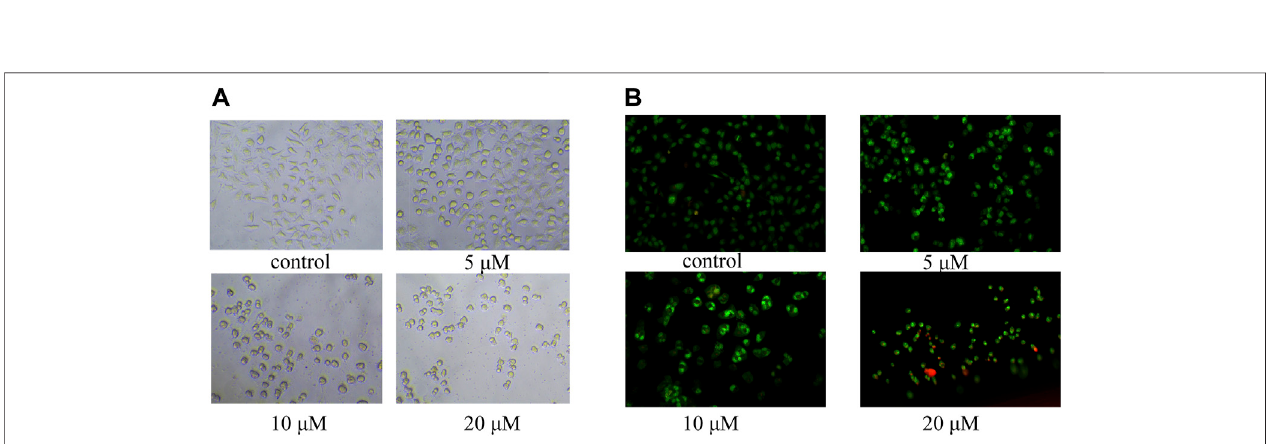
FIGURE 9 | Apoptosis induced by siragrosvenin D in MCF-7 cells detected by the fl uorescence microscope. (A) Morphology of the cells after being treated with siragrosveninD(0,5,10,and20 μ M)for24 h. (B) PercentageofapoptoticcellsbyAO/EBstainingafterbeingtreatedwithsiragrosveninD(0,5,10,and20 μ M)for24 h.